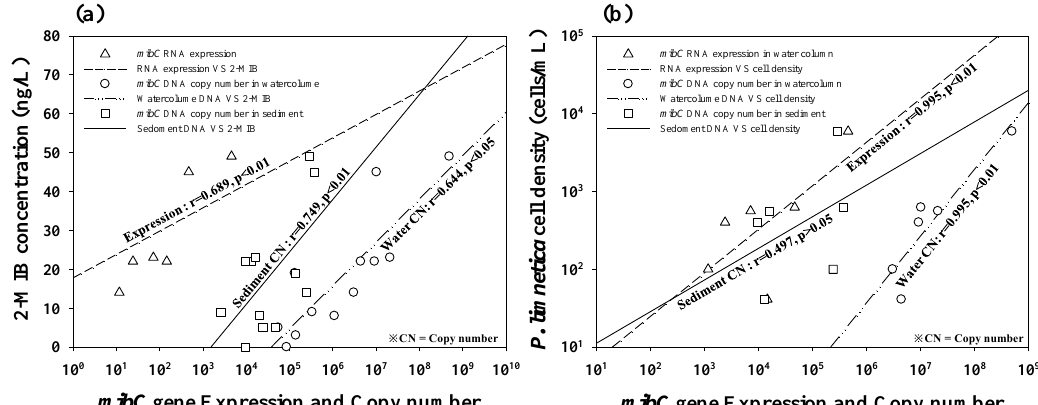
Figure 6. Regression lines for the correlation among mibC196 primer-derived amplicon copy number, gene expression, 2-MIB concentration, and Pseudanabaena limnetica cell density in the water column and sediment of Gong-ji Stream in 2015–2016. The 2-MIB compound concentration ( a ) and P. limnetica cell density ( b ) showed a linear relationship with the mibC gene amount (copy number and gene expression level). The amount of mibC was significantly correlated with both the 2-MIB concentration and P. limnetica cell density in the water column.